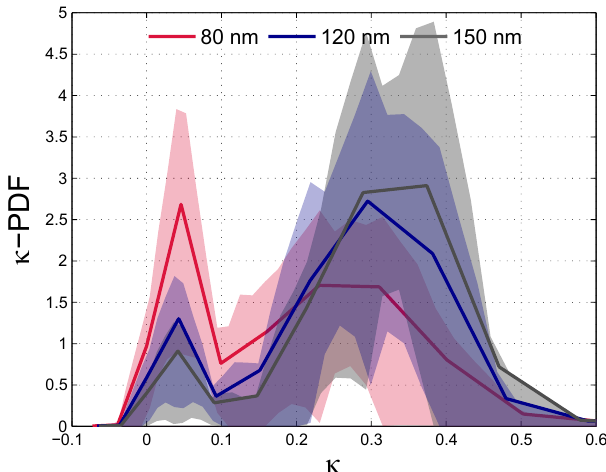
Figure 2. Mean κ -PDFs of 80, 120 and 150nm particles calculated over the whole data set. The shaded areas represent the ranges be- tween the 25th and 75th